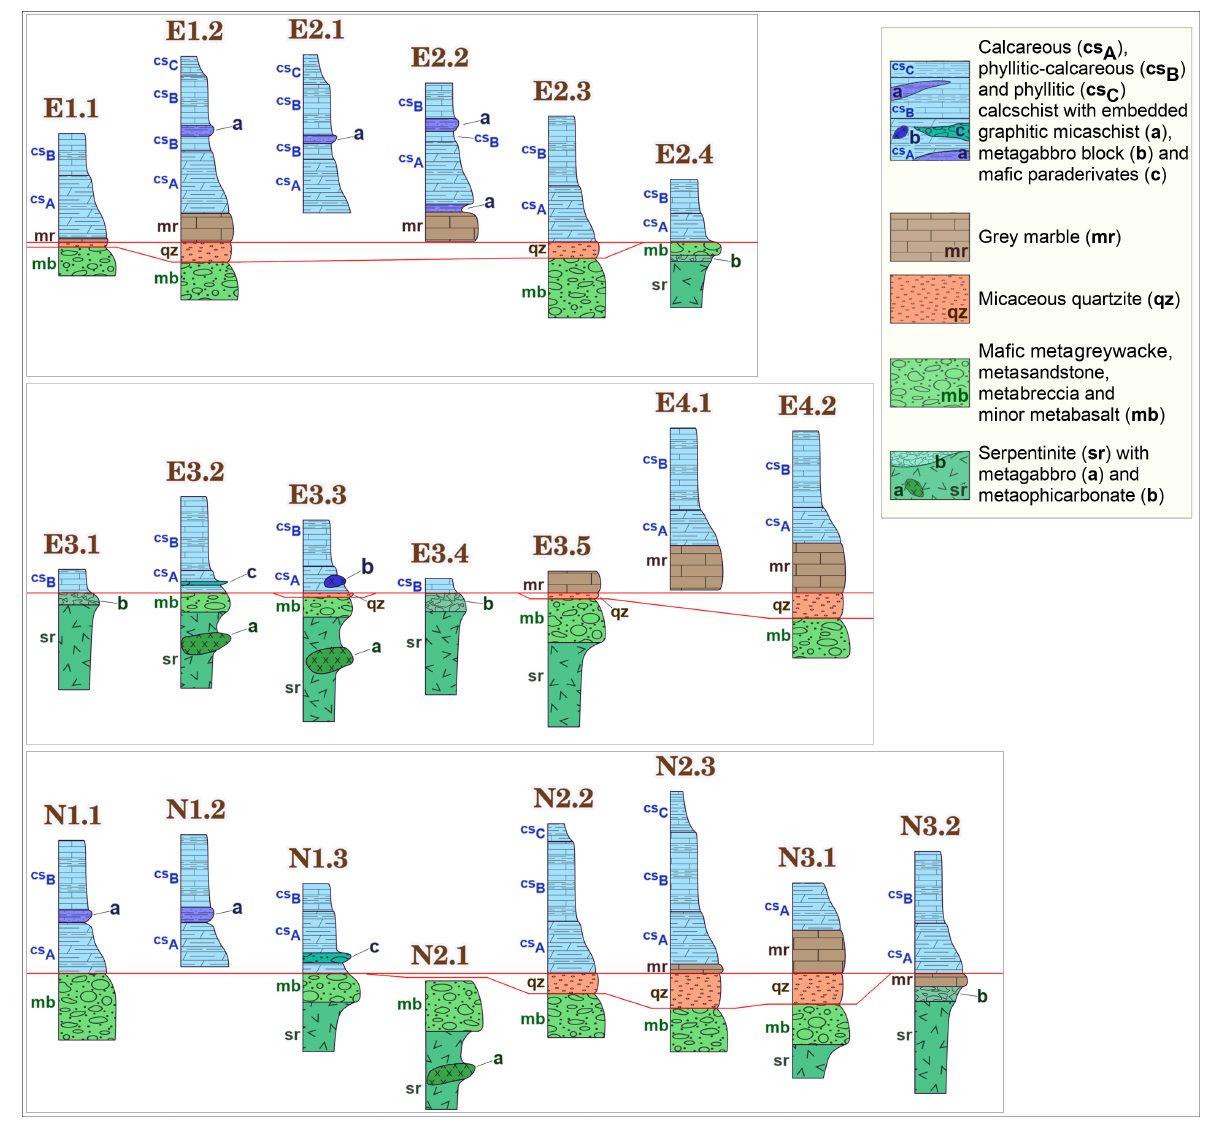
Figure 6. Lithostratigraphic columns (not to scale) reconstructed along the E–W ( E1 and E2 above; E3 and E4 middle) and the N–S-oriented ( N1 , N2 , and N3 below) cross sections of Figures 2b and 3. The stratigraphic base of both gray marble and quarzite is correlated throughout all columns with a red